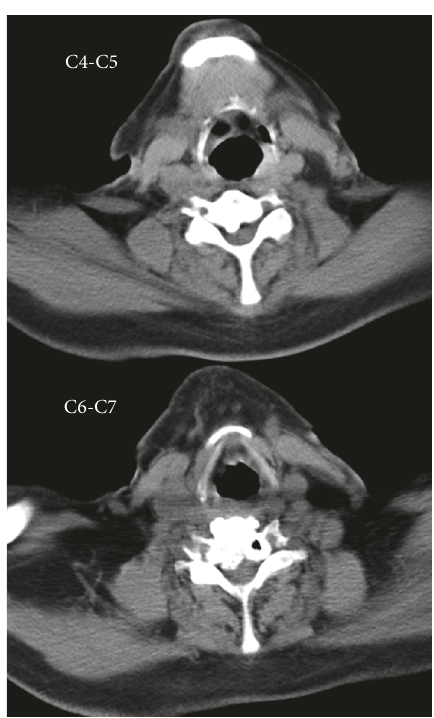
Figure 3: Neck CT scan C4-C5, C6-C7.